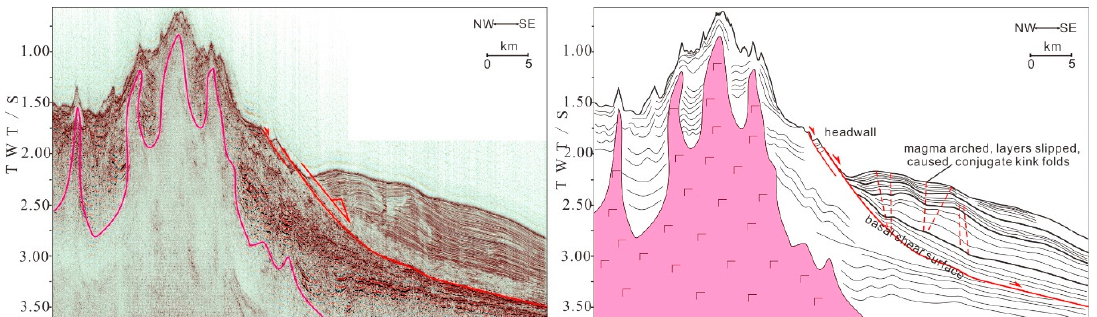
Figure 3. Seismic reflection profile of Line 2 is a landslide induced by piercing intrusive rocks and interpretation model. Energies 2019 , 12 FOR PEER REVIEW